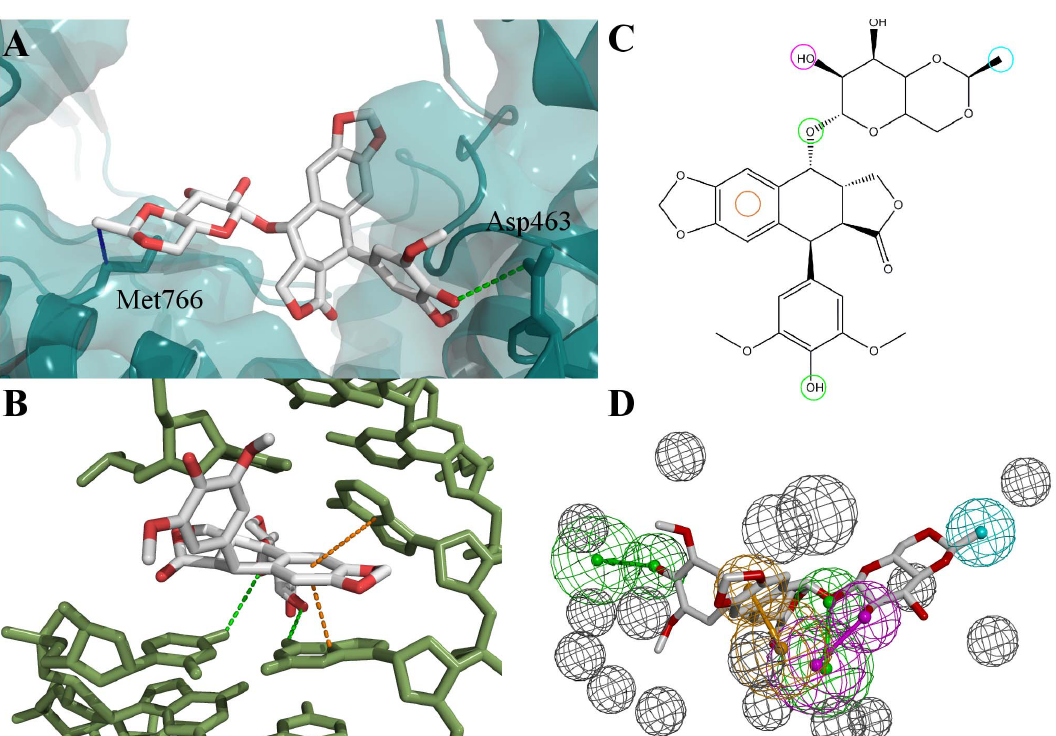
Fig. 1. Docking pose of etoposide in Top2 a and development of complex-based pharmacophore. A) Docking pose of etoposide relative to Top2 a . Protein backbone and surface shown in cyan. Two residues interacting with etoposide are shown as sticks. B) Docking pose of etoposide relative to DNA. DNA residues shown as green sticks. Hydrogen bonds indicated as green, hydrophobic interactions as blue and stacking interactions as orange lines. C) and D) 2D- and 3D-representation of complex-based pharmacophore developed from the etoposide docking pose. Colour code of pharmacophore features: hydrogen bond acceptor (HBA), green; hydrogen bond donor (HBD), pink; hydrophobic group, blue; cyclic p -interaction (CYPI), orange; excluded volume, grey.